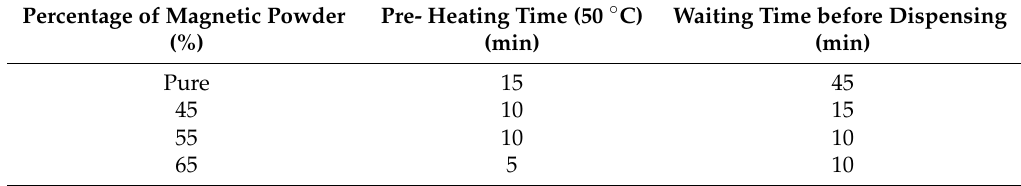
Table 3. Process conditions for obtaining the AW4510 + HW4804 based epoxy composite core with 1 mm in diameter and 2 mm height. The pre-heating was done before dispensing the composite to enhance the viscocity of the mixture. The post curing was done at 100 ◦ C in an oven for 1 h. Percentage of Magnetic Powder Pre- Heating Time (50 ◦